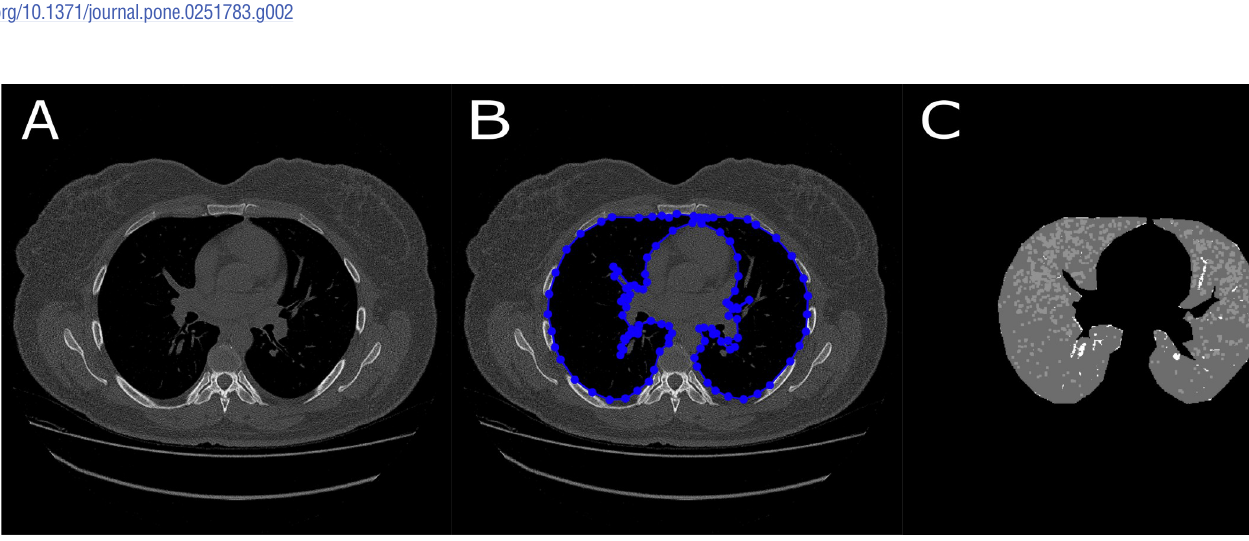
PLOS ONE | https://doi.org/10.1371/journal.pone.0251783 June 10, 2021 6 /